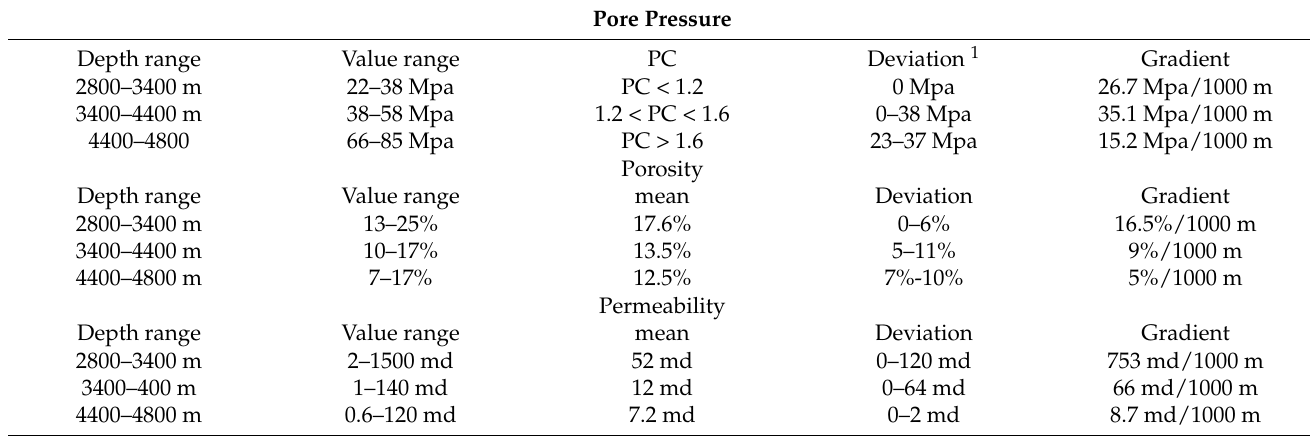
Table 2. Pore pressure, porosity, and permeability of the Pinghu area.